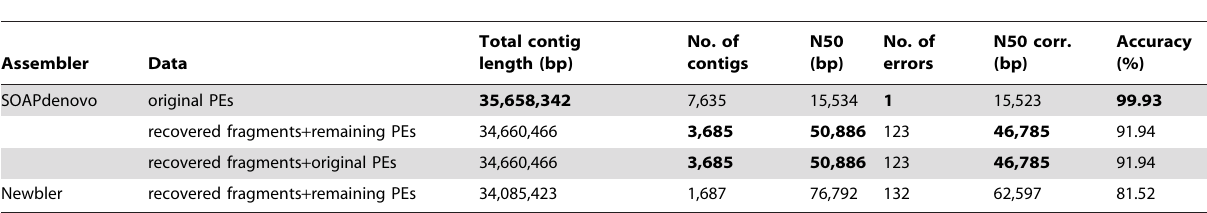
Table 11. Assembly statistics on three types of simulated data of human chromosome